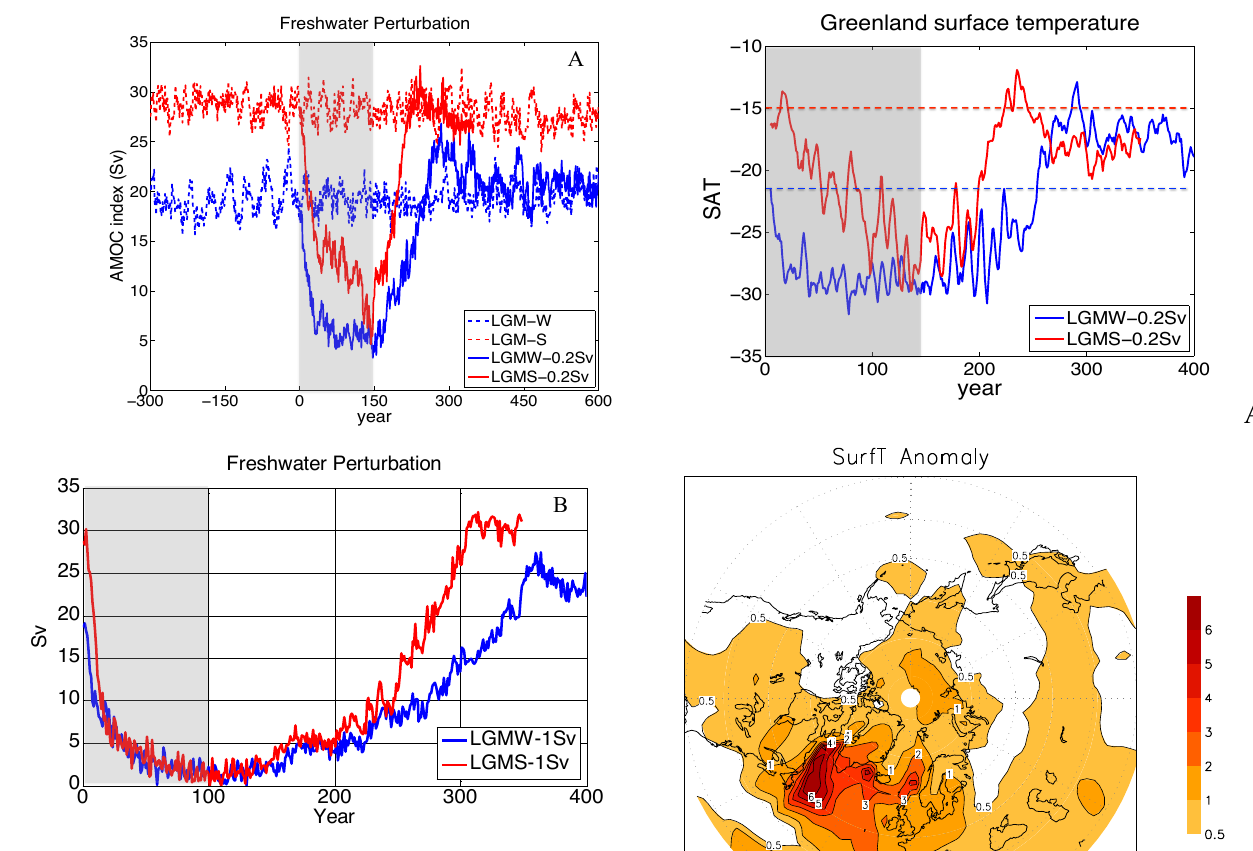
Fig. 8. Time series of AMOC in the 0.2Sv ( A : FWP lasts for 150yr) Figure 8 Time series of AMOC in the 0.2Sv (A: FWP lasts for 150 years) and the 1Sv ( B : FWP lasts for 100yr) hosing experiments LGMW-e and the 1Sv (B: FWP lasts for 100 years) hosing experiments LGMW-e (blue) and LGMS-t deep (red), respectively. The hosing experiments started from the model year 2700 in each LGM simulation. Dashed Fig. 9. (A) Surface air temperature (SAT) in the latitude belt of 60– (blue) and LGMS-t (red), respectively. The hosing experiments started deep lines represent the LGM control runs (A) , and solid lines the hos- 70 ◦ N in the North Atlantic in LGMW-0.2Sv (blue) and LGMS- ing experiments (A, B) . Despite the different amount of FWP, a from the model year 2700 in each LGM simulation. Dashed lines represent 0.2Sv (red). 5yr running mean was used to filter out the high- transition between the states LGMW-e and LGMS-t deep is not trig- frequency signals of the SAT. The red and blue dashed lines indicate the LGM control runs (A), and solid lines the hosing experiments (A, B). gered. A robust overshoot of the AMOC is only detected in quasi- the pre-hosing reference level for LGMS-t deep and LGMW-e, re- equilibrium ocean states (see also Fig. S7). spectively. (B) Excess surface temperature increase related to the Despite the different amount of FWP, a transition between the states overshoot of the AMOC (270th–300thyr) in LGMW-0.2Sv. The LGMW-e and LGMS-t is not triggered. A robust overshoot of the AMOC pronounced temperature increase relative to LGMW in the North deep Hemisphere is up to 6.8 ◦ C at convection sites in the Northern At- is only detected in quasi-equilibrium ocean states (see also Fig. S7).